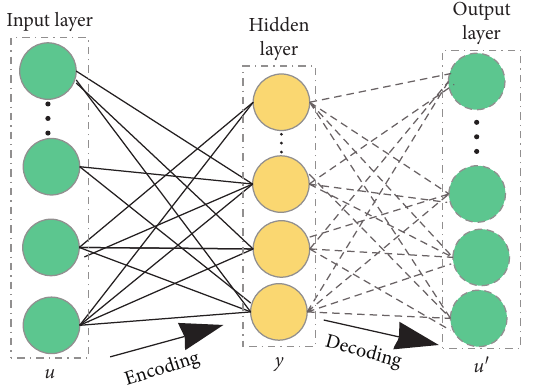
Figure 5: Structure of stacked of the auto